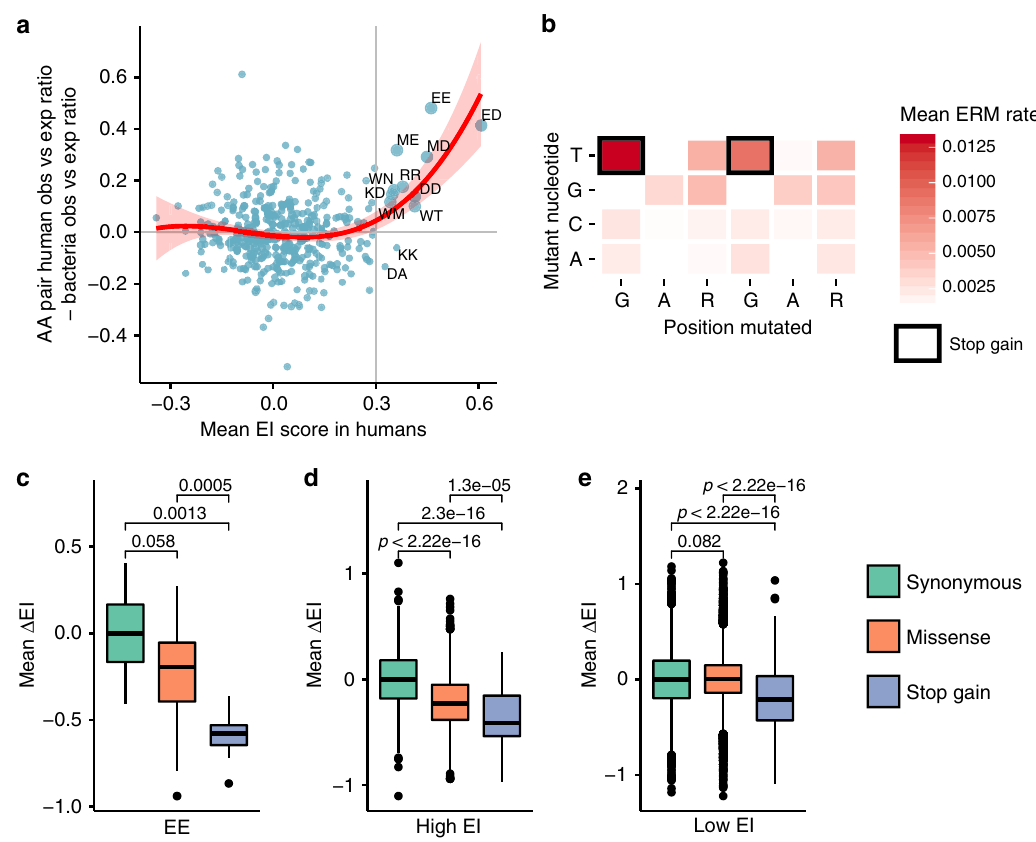
Fig. 4 ESE activity is associated with speci fi c amino acid pairs. a All 4096 hexamers were associated with exonic splicing enhancer activity (mean EI) and the amino acid (AA) doublet motifs they encode in genomes with splicing (human) or without splicing (bacteria). The enrichment of AA pairs in human relative to bacterial genomes was analyzed as a function of mean EI score. AA pairs with EI score >0.3 and human enrichment >1 are highlighted (upper right). Cubic polynomial regression (95% con fi dence band). b EE corresponds to the GARGAR ESE. The mutability of GARGAR mutations at each position was plotted (mean ERM rate based on an average over fl anking contexts of GARGAR in the human genome). Stop gains have high mutability (black boxes). c – e All possible mutations in the human genome were binned by their predicted effect on protein function, scored for their change in ESE activity (mean Δ EI), and assigned to the amino acid pair in which they belong. Severity of splice disruption was found to be concordant with severity of protein disruption (synonymous < missense < stop gain) for c EE/GARGAR ( n = 8 synonymous, 56 missense, 8 stop mutatio n s), d high EI (>0.3) ( n = 306 synonymous, 980 missense, 64 stop gain mutations), e but not low (<0.3) EI AA pairs ( n = 16,010 synonymous, 46,732 missense, 2742 stop gain mutations). c – e The boxplots indicate the median (middle line), fi rst and third quartiles (box), and 1.5× IQR (whiskers); pairwise p- values from Mann – Whitney two-tailed test. Source data are provided as a Source Data fi le.